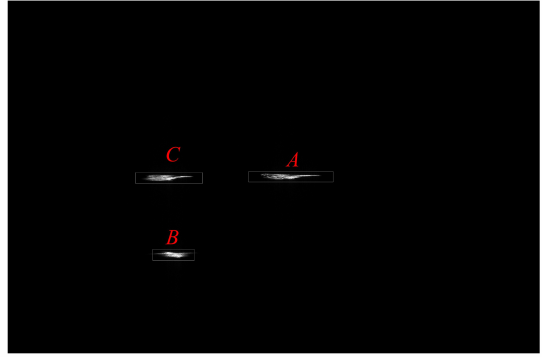
Figure 11. SAR rough focusing and ship detection result.